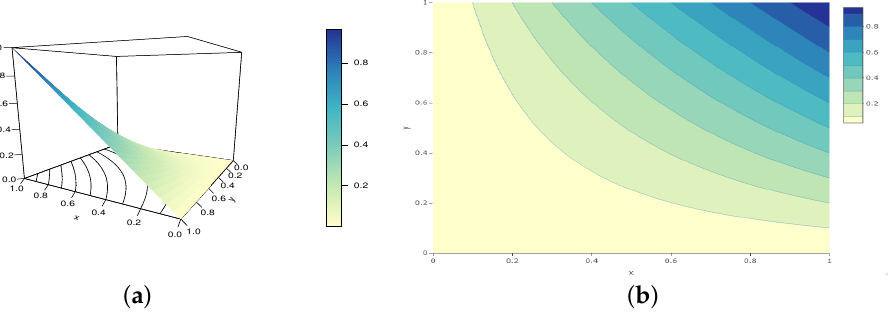
Figure 2. Illustrations of the ( a ) perspective plot and ( b ) contour plot of the GCC copula for the following configuration: a = − 1/2, b = 2, and c = 1, belonging to Configuration 2.